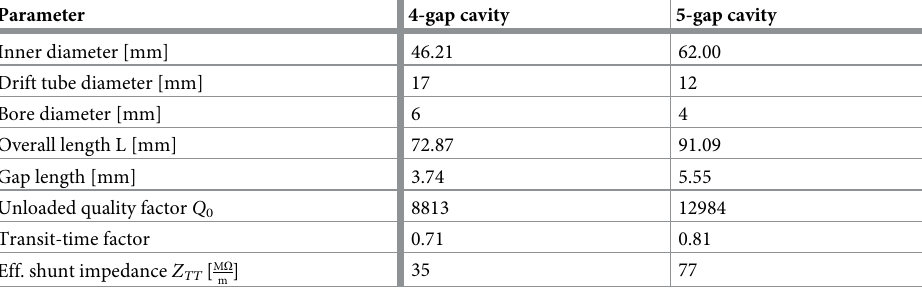
Table 1. Parameter list of basic buncher